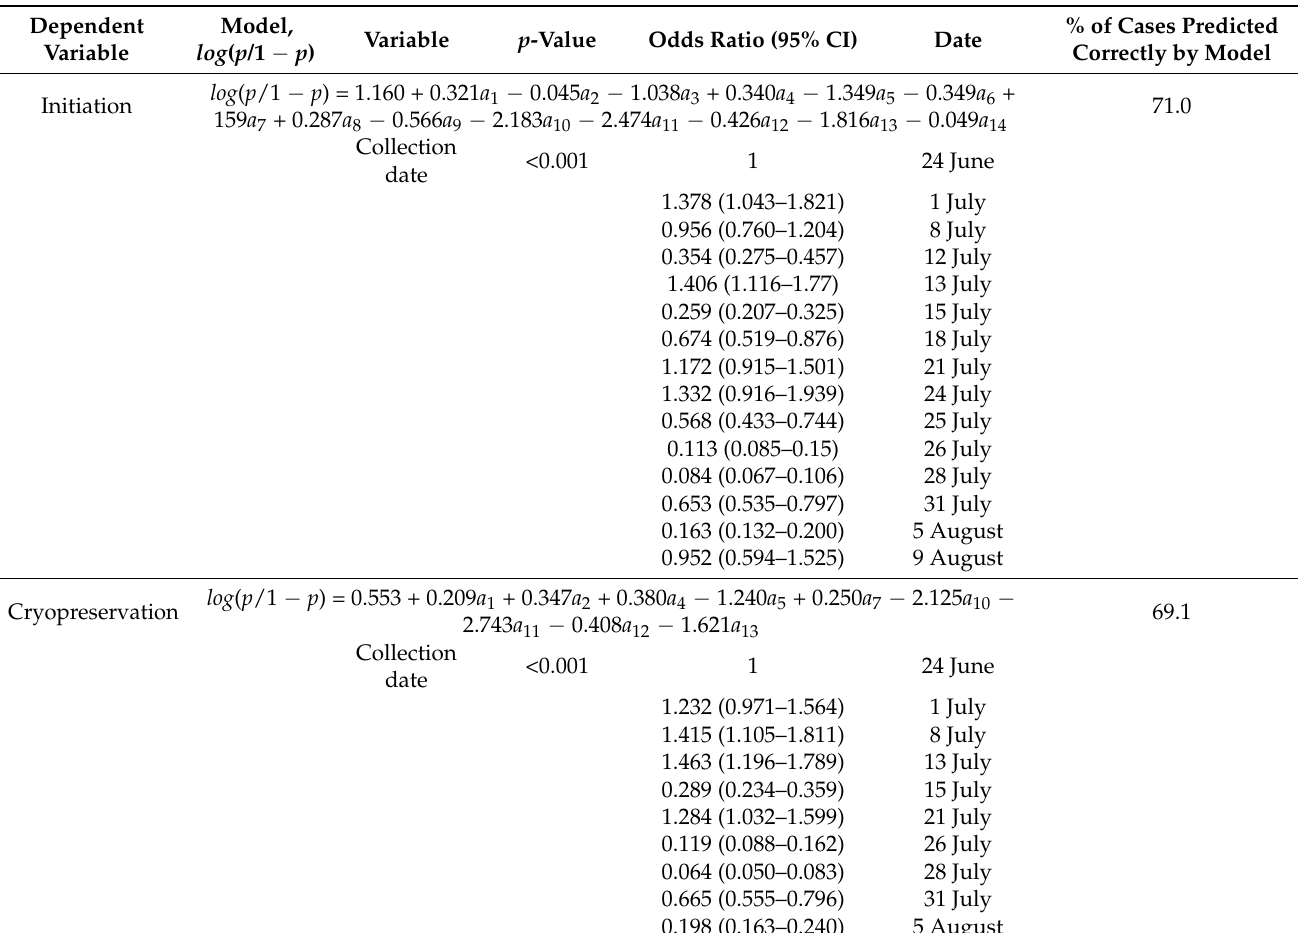
Table 1. Logistic regression models used to analyse binary response in the initiation (proliferating ET or not) and cryopreservation (cryopreserved or not). In the models, a1 to a15 are design variables for cone collection